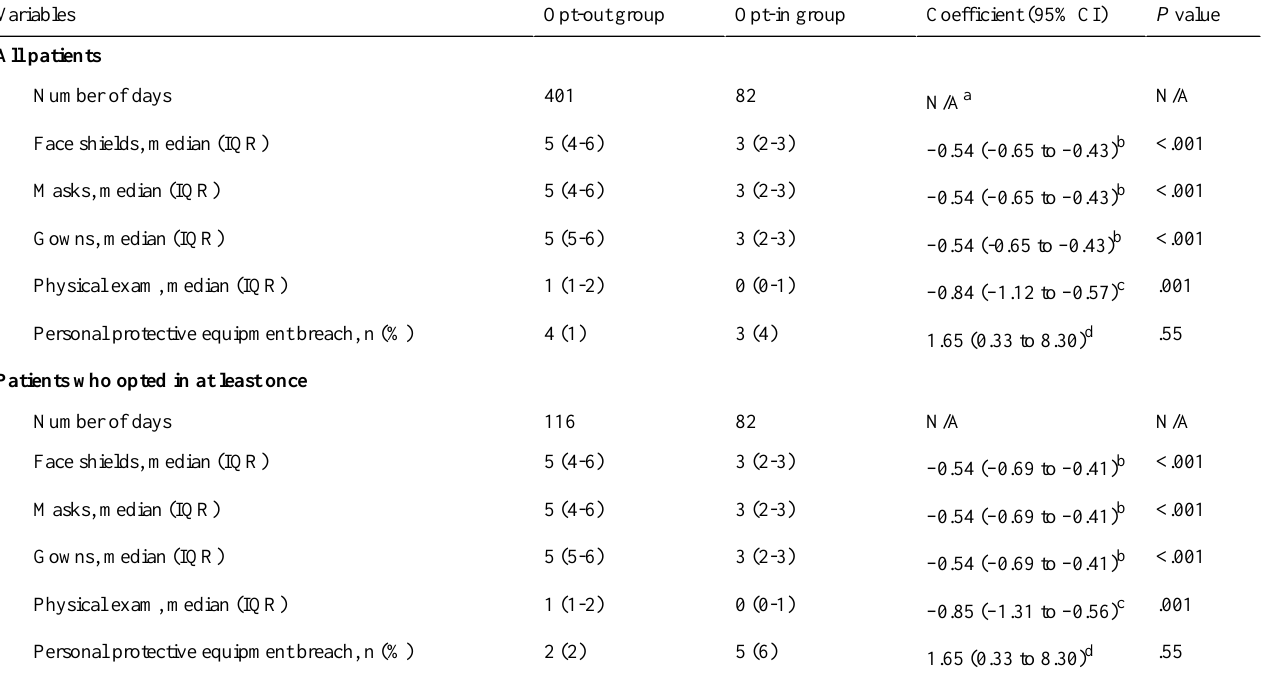
Table 2. Daily personal protective equipment use rates among patients with and without virtual care.